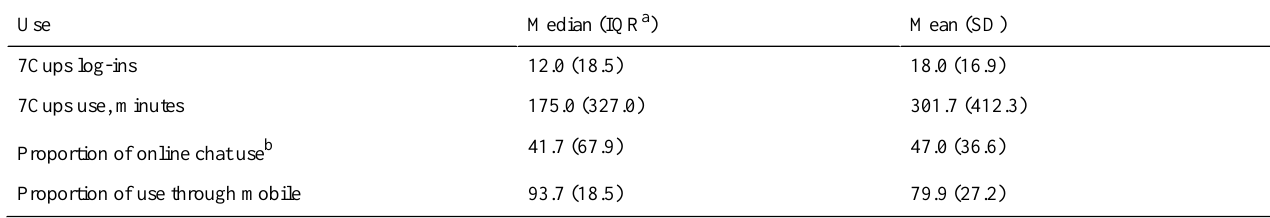
Table 2. Use of 7Cups enhancement during the 30-day examination